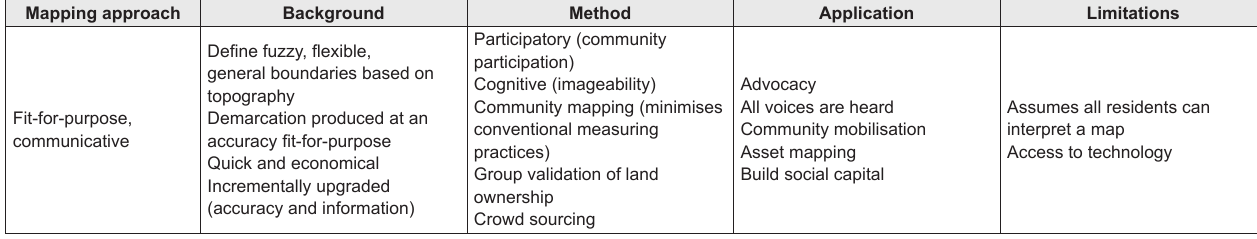
A summary of the fit-for-purpose communicative mapping approach Mapping approach